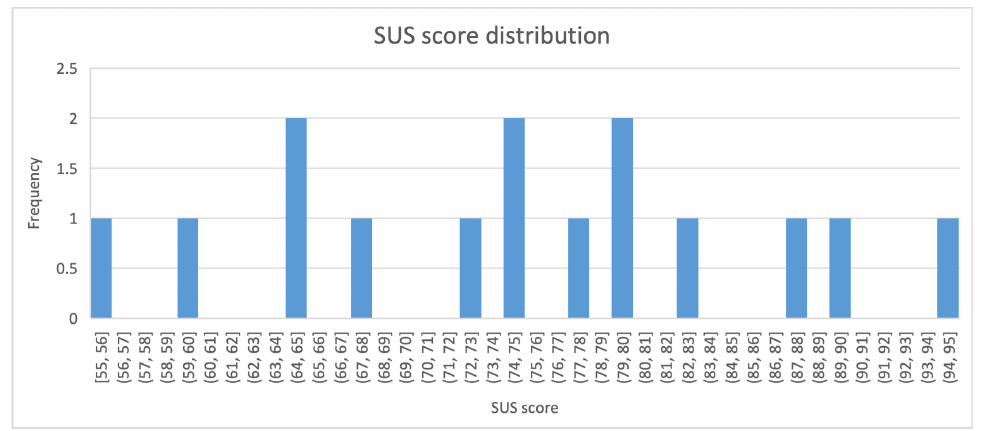
Figure 25. SUS scores of the interface developed for the analysis of biological efficacy in by-products use case. The X-axis indicates a certain range of the score. The Y-axis indicates the number of participants who gave the score within the